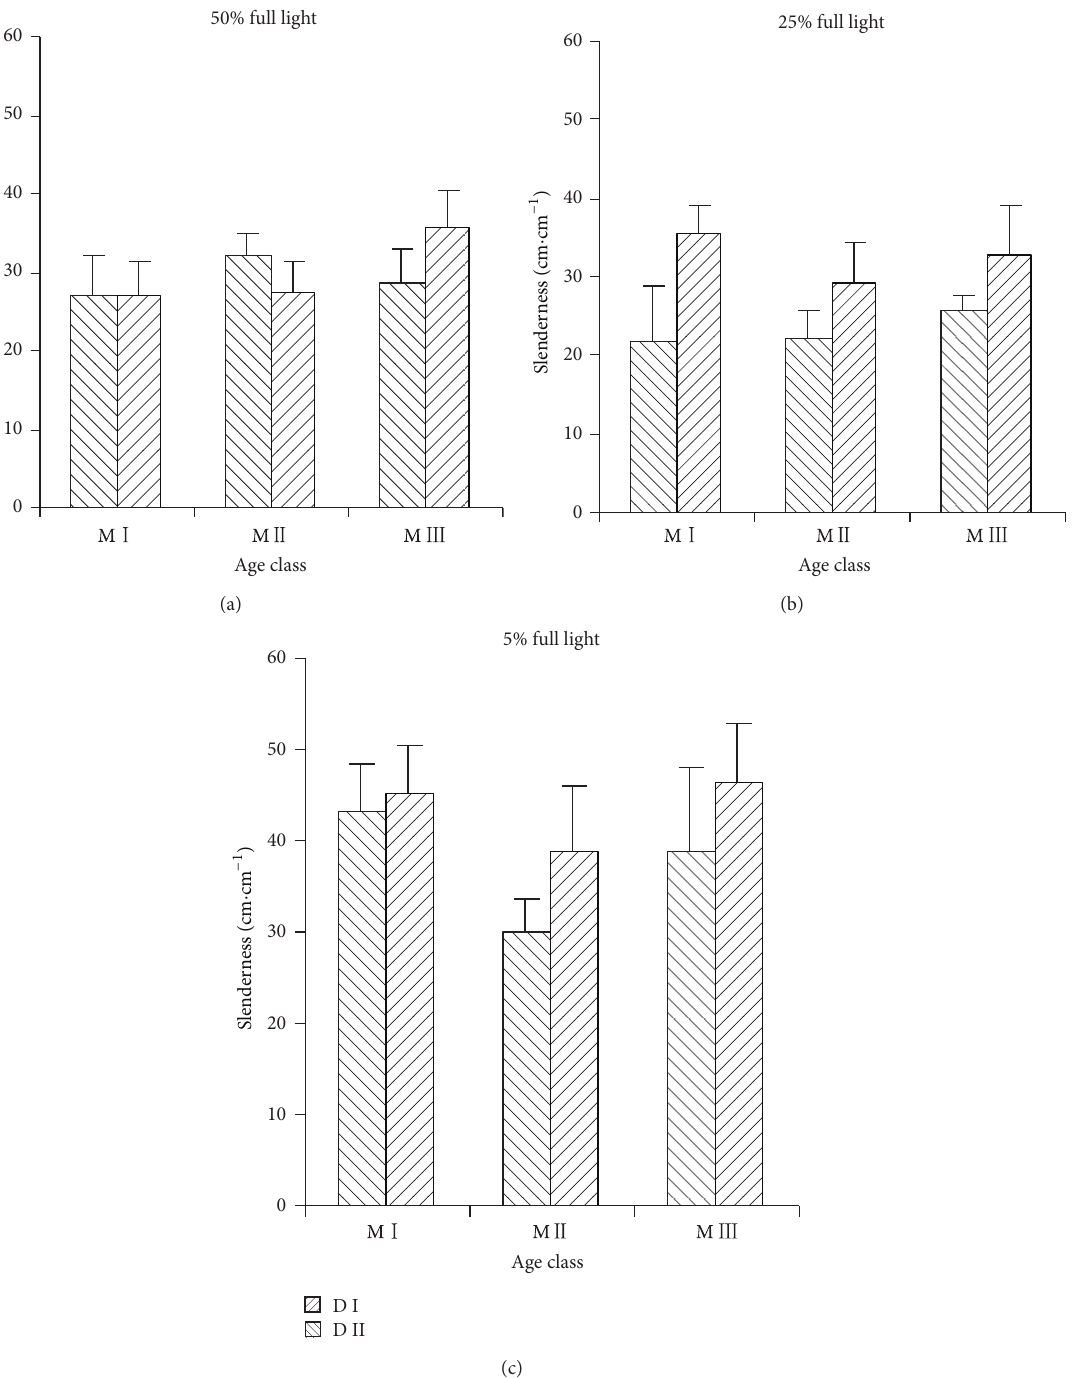
Figure 4: Effects of age and stand density of mother tree on seedling